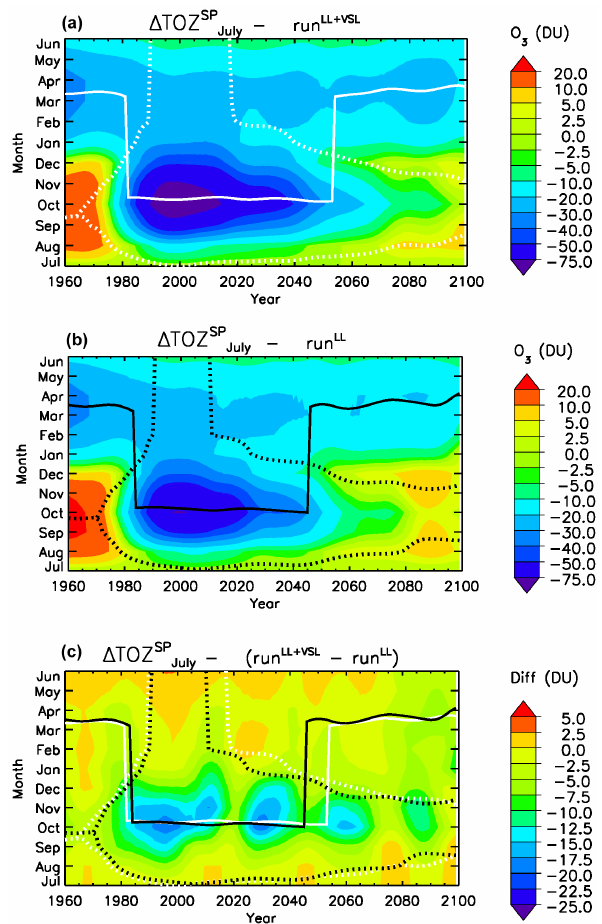
Figure 8. Evolution of (cid:49) TOZ SP as a function of the year July and month. (a) run LL + VSL ensemble mean, (b) run LL ensem- ble mean and (c) absolute difference between the simulations. (cid:49) TOZ SP baseline adjustments were computed relative to the July modelled TOZ SP in July of the preceding winter for each year = TOZ SP − TOZ SP ) . The solid line indicates the lo- ( (cid:49) TOZ SP July Time July cation of the (cid:49) TOZ SP annual minimum for each ensemble (white July for run VSL and black for run noVSL ) , while the dashed lines indicate the shifts in the (cid:49) TOZ SP local maximums arising on each side of July the springtime minimum (see Fig. 7).